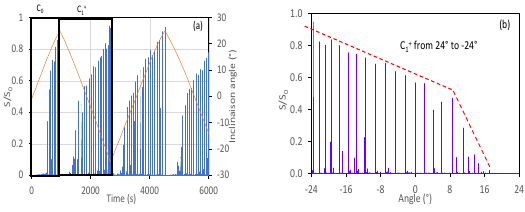
Figure 3. (a) Surface activity S / S 0 measured as a function of the recording time during a multi-cycle experiment composed of 4 full-cycles (blue line). During the first quarter-cycle and each following half-cycle, the inclination angle θ changes lin- early with the time (red lines). (b) Activity of the C + following C 0 as a function of the inclination